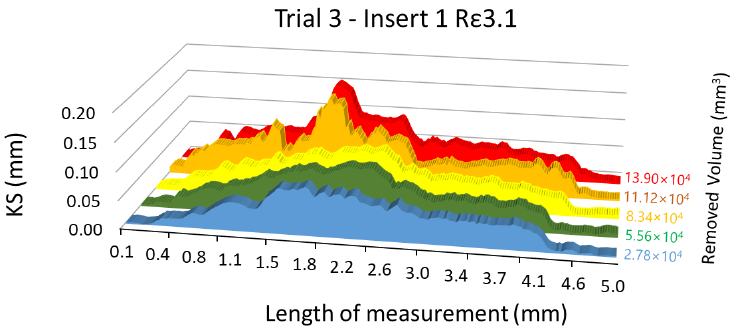
Figure 18. Evolution of KS.